Question: Sum up the contents of this chart in one sentence.
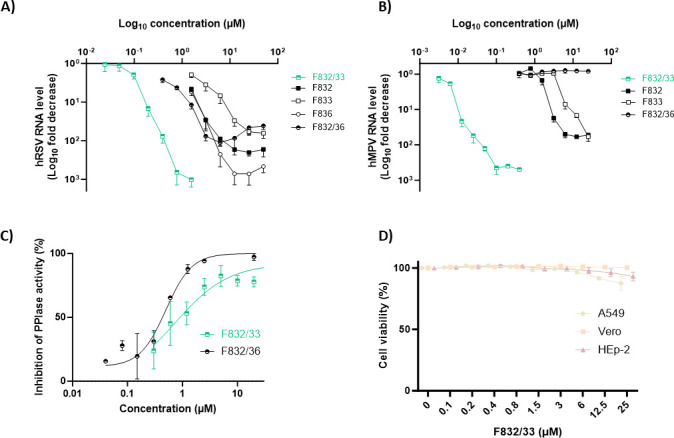
Answer: In vitro activity of parental compounds F832, F833, and F836, as well as optimized derivatives F832/33 (green) and F832/36, against hRSV ( A ) and hMPV ( B ). ( C ) Inhibition of CypA PPIase activity by F832, F833, and their derivative F832/33. ( D ) Cell viability assay in A549, Vero, and HEp-2 immortalized cell lines exposed to increasing concentrations of F832/33. Data are shown as mean ± SD from at least two independent experiments.